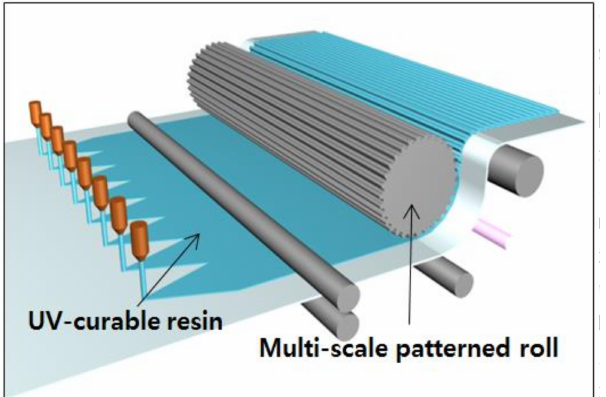
Figure 7. Schematic illustration of roll-to-roll process used to produce superhydrophobic polymer film with a WEDM-machined metallic roll.